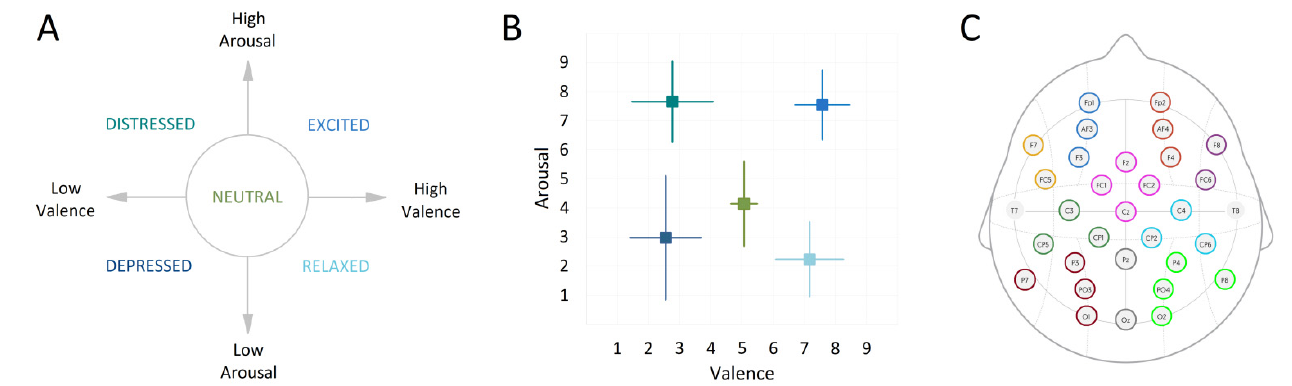
Figure 2. ( A ) Emotion descriptors used for performance instructions; ( B ) mean results of subjective self-assessment on the experienced emotional arousal and valence levels across each experimental trial of all participant (color coding is similar as in A); ( C ) the group of electrodes into regions of interest (ROIs): mid-frontal left (1) and right (2), left (3) and right (4) frontal, centro-parietal left (5) and right (6), parieto-occipital left (7) and right (8), fronto-central (9) and central parieto-occipital